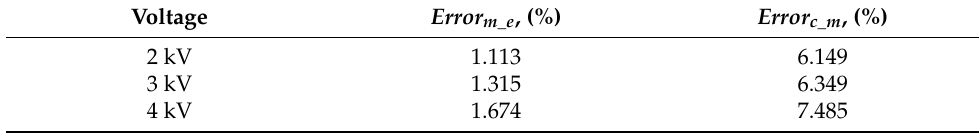
Figure 15. The area errors of the DEA under different excitation voltages: ( a ) Error m _ e and ( b ) Error c _ m . Table 2. Maximum errors of the effective three units modeled at different excitation voltages.